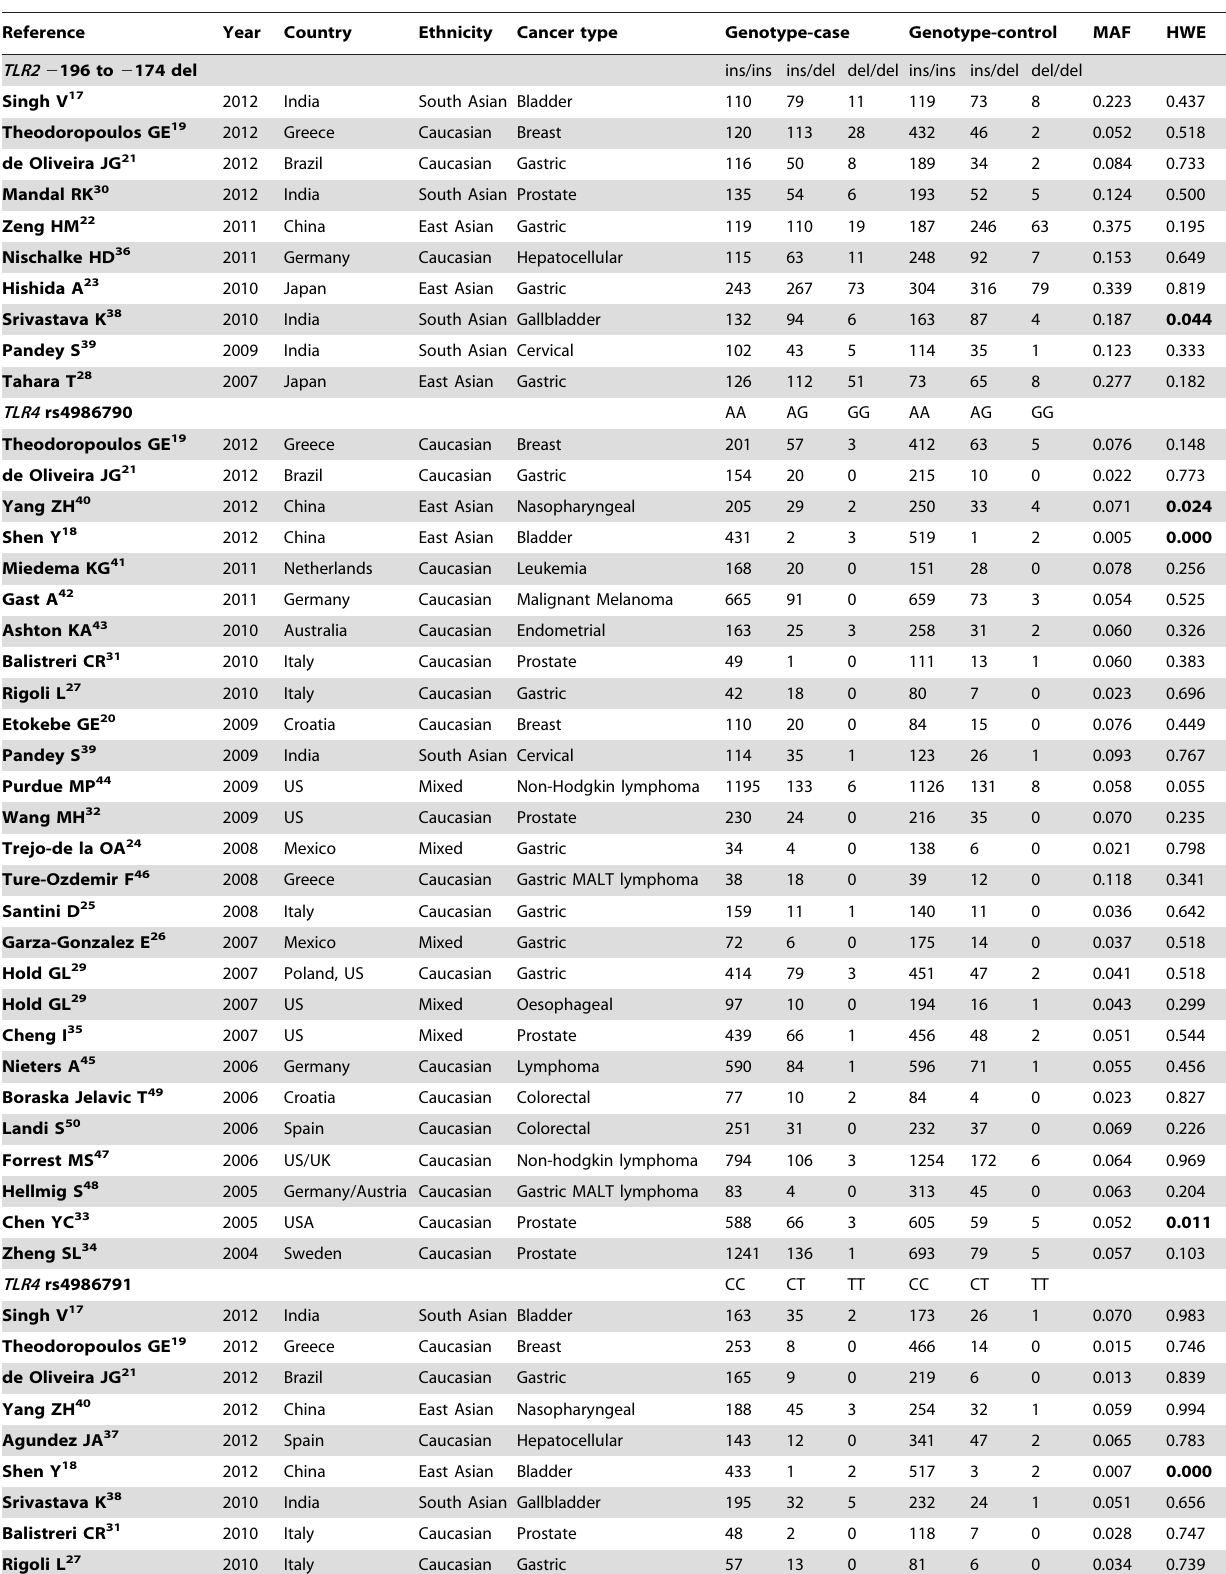
Table 1. Characteristics of literatures included in the